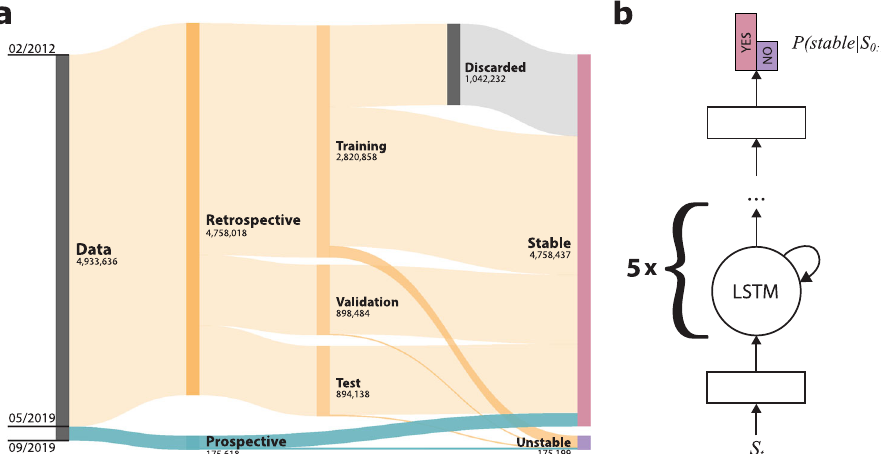
Fig. 2 Data organization and model architecture. The complete de-identi fi ed retrospective and prospective data set contains 2,318,506 inpatient hospital admissions and 26,201,030 records of vital signs (VSs) between 2012 and 2019, yielding 4,933,636 VS input sequences used by our model (shown). The retrospective data set included all data through April 2019, while the prospective collection ranged from May to August 2019. Unrealistic, possibly mistyped VS values and records with any missing data after imputation were discarded. We split the retrospective data into training (70%), validation (15%), and test (15%) sets by patient visit, so the sequences drawn from one visit were only included in one of the groups. Some training data sequences with stable outcomes were discarded to balance the positive and negative cases ( a ). We used a deep recurrent neural network with two dense layers and fi ve successive long short-term memory (LSTM) cells. After receiving a sequence of samples S0:T, the model predicts the probability of the patient becoming unstable during the night. We inserted a batch norm and dropout layer before the last fully connected layer ( b